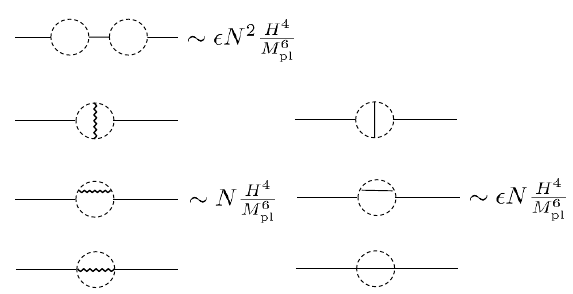
Figure 3 . Two loop corrections to h (cid:16)(cid:16) i . Wavy lines denote the graviton propagator. The double sunset graphs dominate when N (cid:29) 1 =(cid:15) .